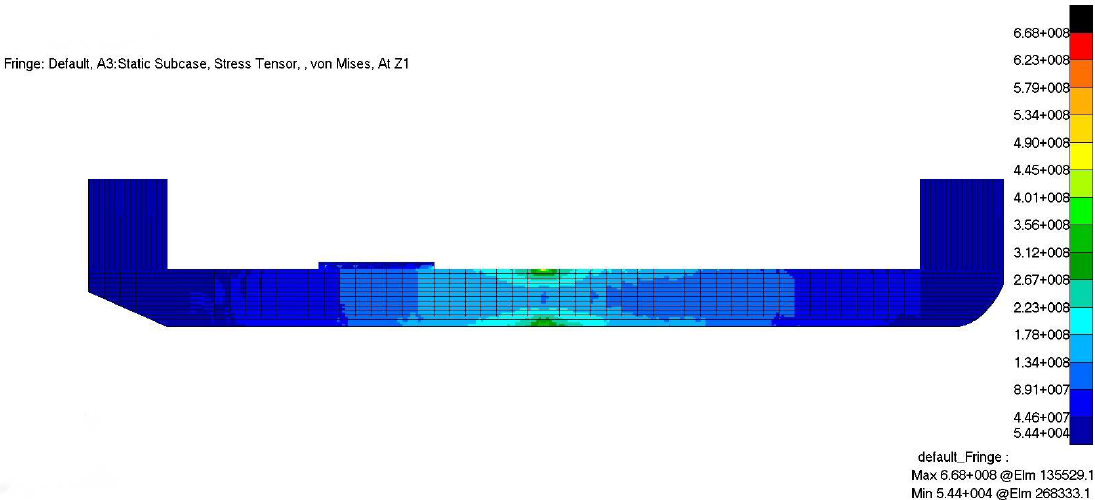
Figure 11. Condition 23 The stress cloud diagram of the whole ship. Table 3. Maximum stress under different support lengths.